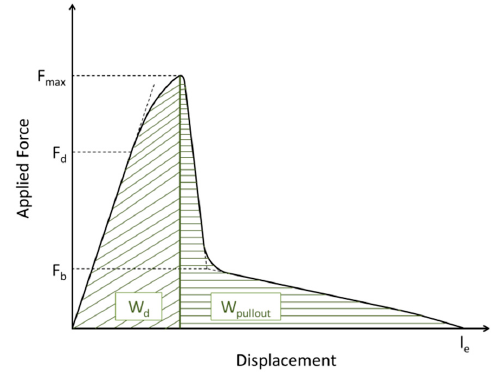
Figure 2. Schematic force-displacement curve recorded during a pull-out test revealing the characteristic points for the calculation of interfacial parameters.